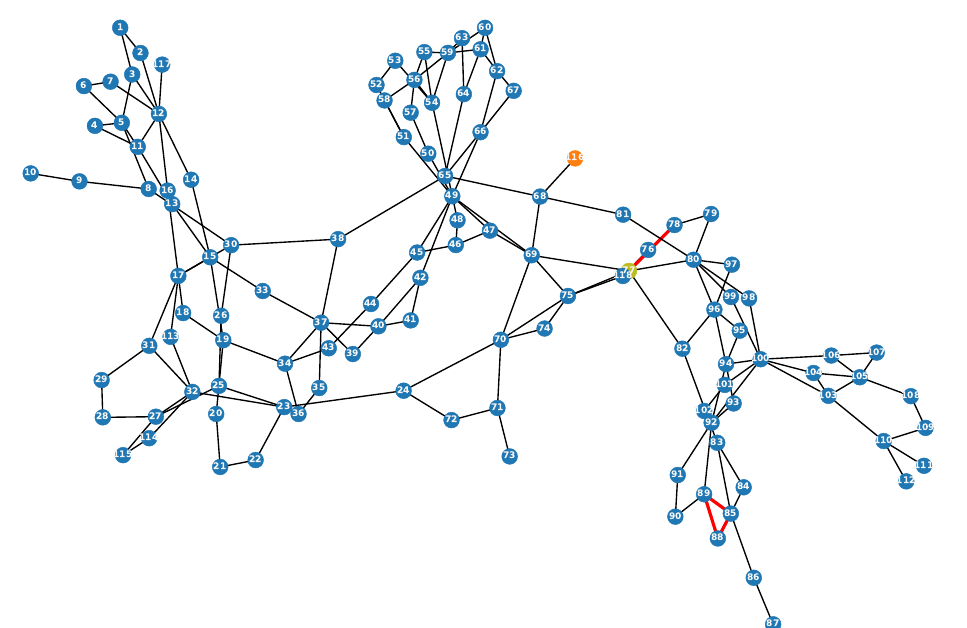
Figure 14. The optimal new 1 × 150 MW RES and mobile MSSSC allocation during Season 2. Red lines indicate the mobile MSSSC deployment locations; light green node indicates the RES location without devices, and orange node indicates the RES location with devices.